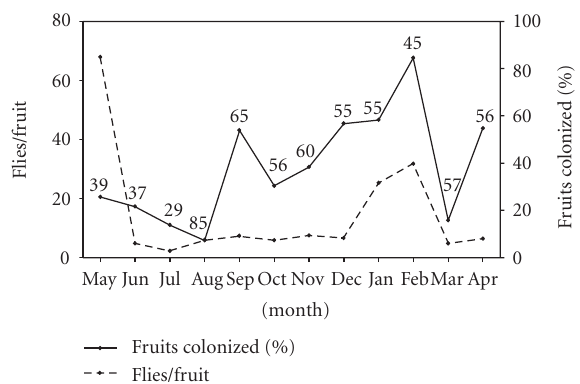
Figure 4: Use of Mauritia flexuosa by drosophilids from May 2006 to April 2007 collected in a gallery forest of the Ecological Reserve of IBGE, Bras´ılia, DF. The dotted line represents the mean number of flies per fruit, and the continuous line the percentage of colonized fruits. Values above the continuous line refer to the total fruits in each